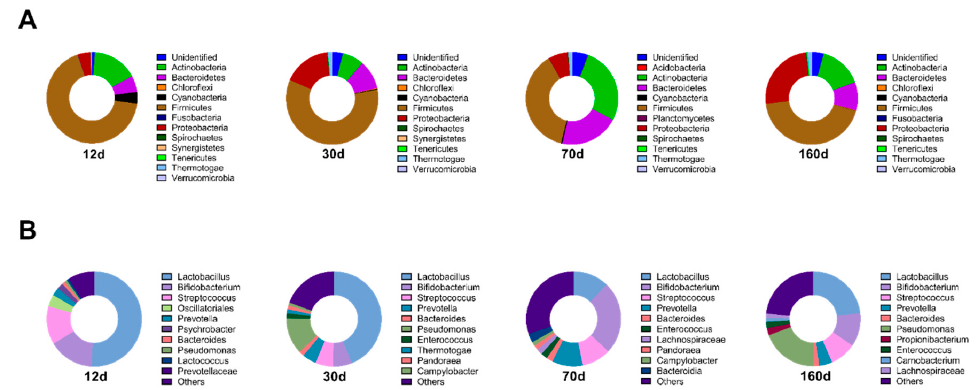
Figure 4. Relative abundance (%) plots of the microbial communities on the surface of dry-aged beef with respect to the aging periods. The top ten most abundant bacteria at the phylum level ( A ) and genus level ( B ) are represented, and the rest of the bacteria were pooled in the ‘others’ category.